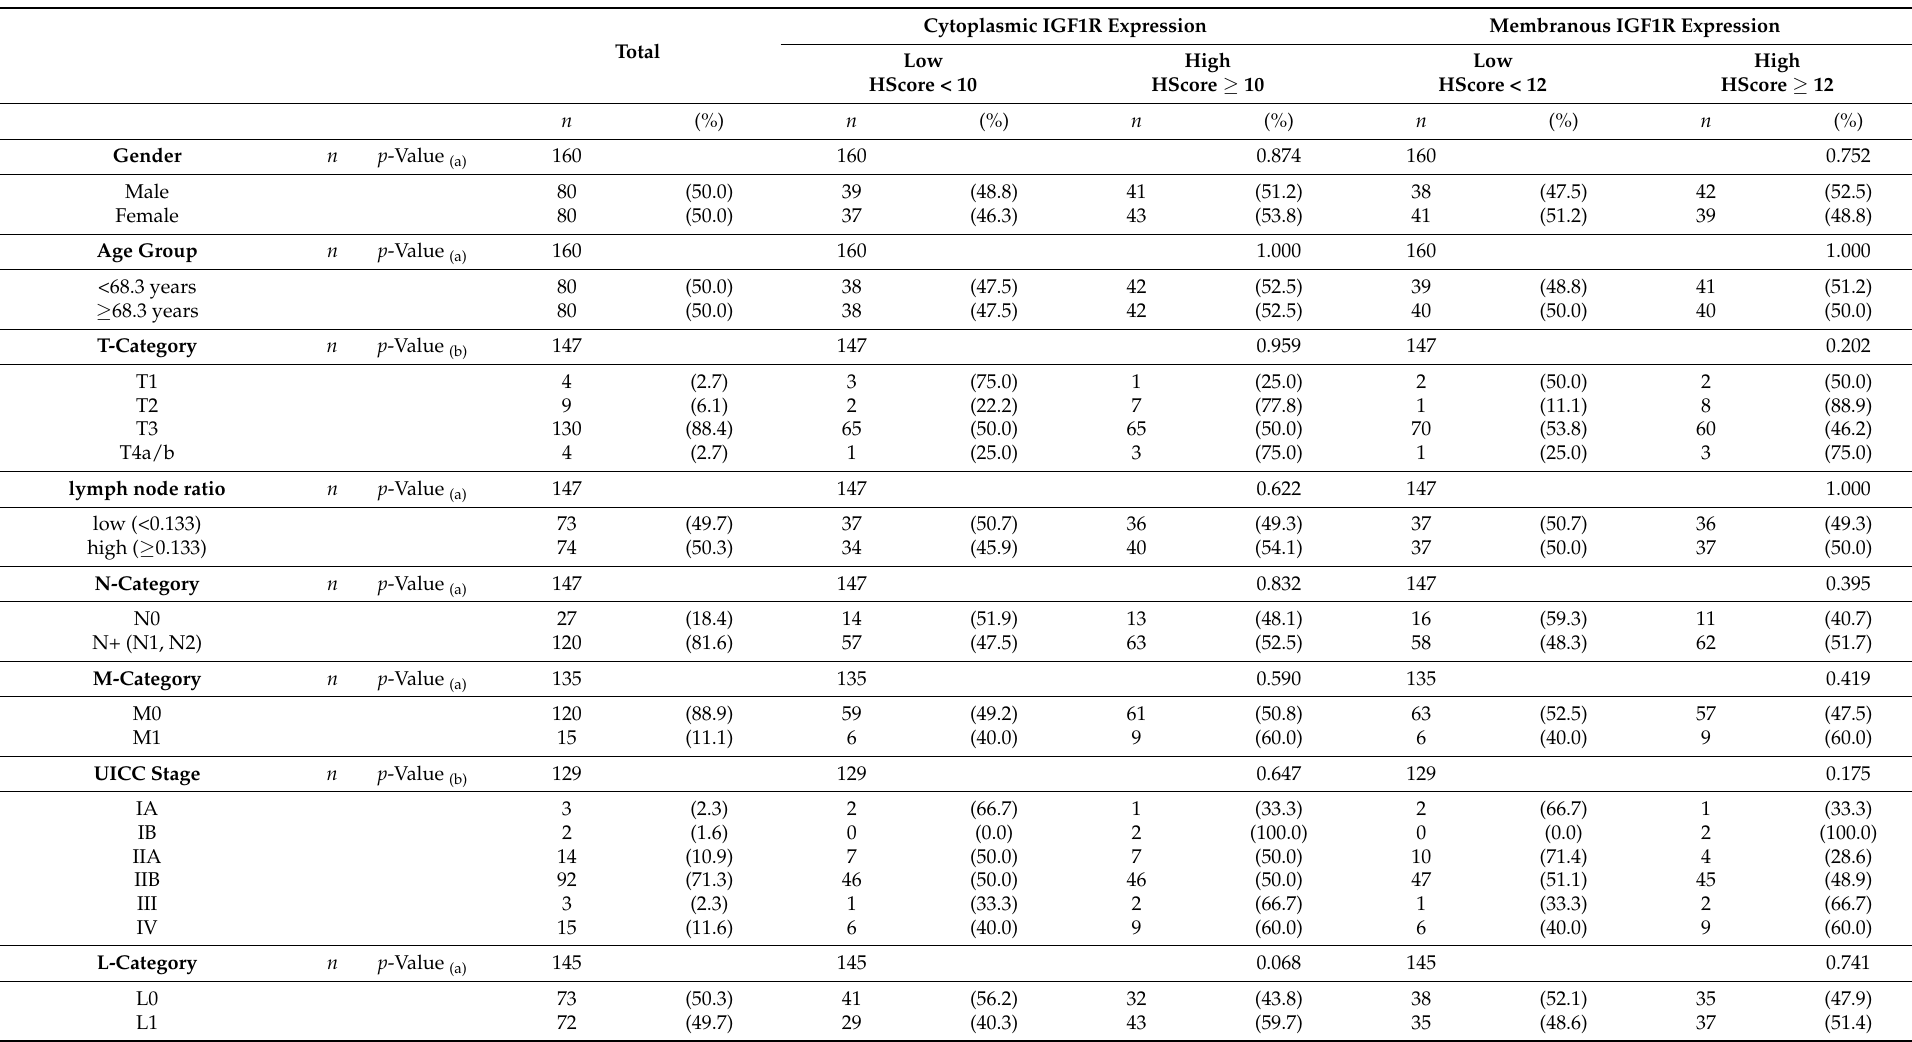
Table 2. Correlation between clinicopathological patient characteristics and the expression of the insulin-like growth factor receptor 1 (IGF1R) in cancer cells in PDAC